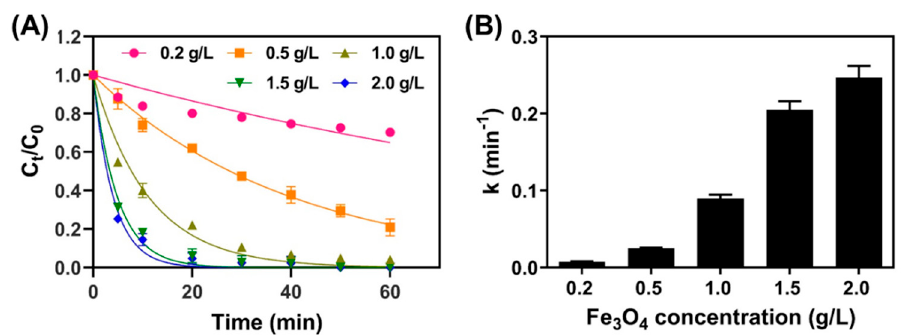
Figure 4. ( A ) TC removal plotted over time for systems with various Fe 3 O 4 concentrations ([PS] = 1.0 mM; [TC] = 41.6 µ M; pH = 4.8), and ( B ) the pseudo first-order rate constants of TC were obtained from the fitting the results in Figure 4A.